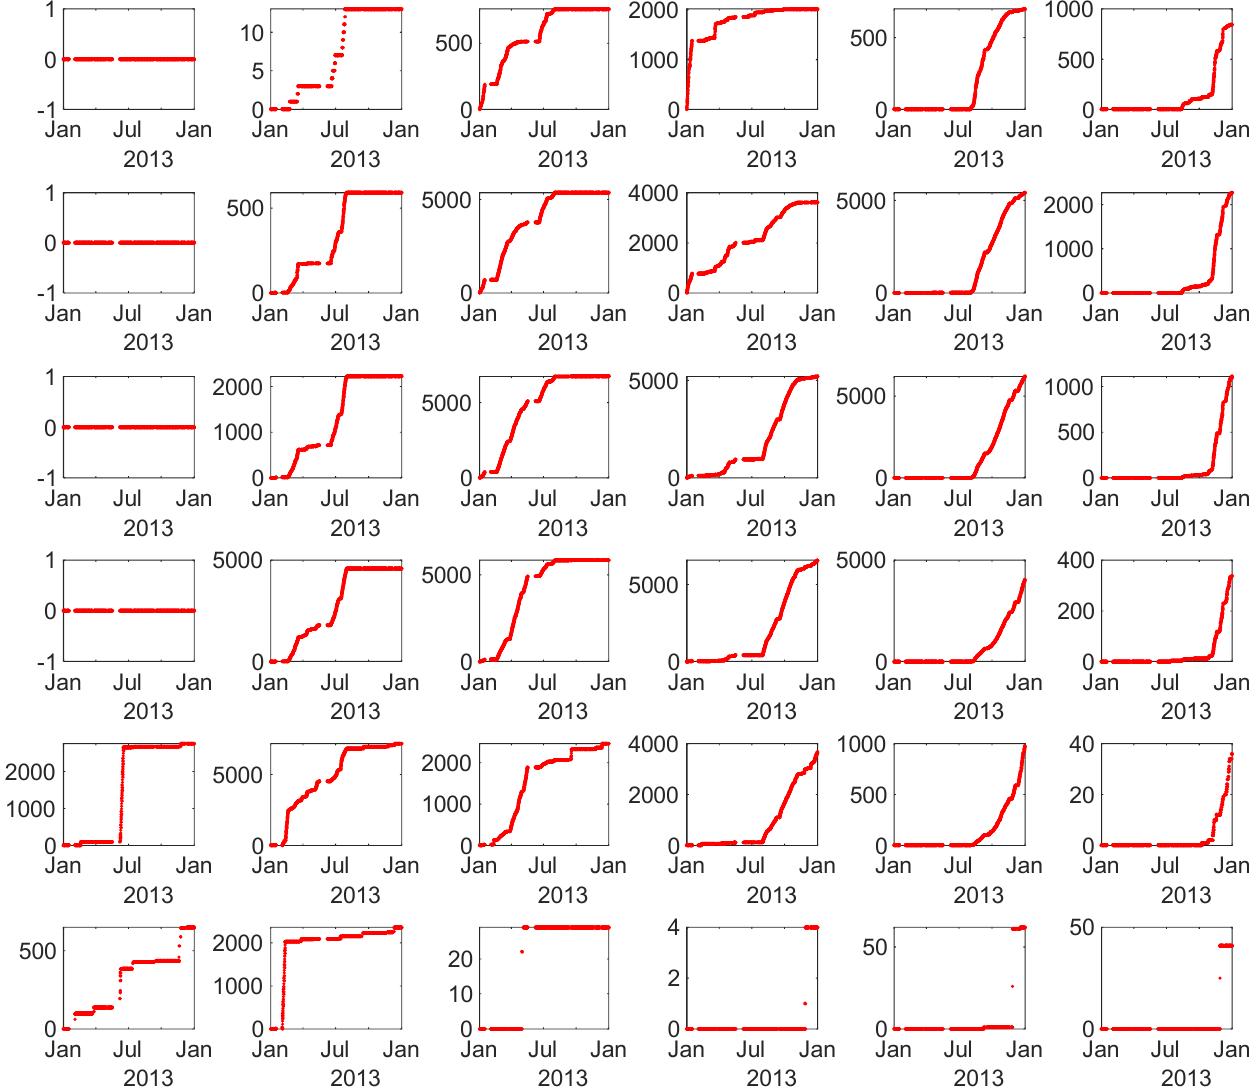
Figure 8. Alternative time series representation of Figure 7 showing each of the 36 quantile cells growth rates. Some cells go through periods of no growth, others are only visited at certain times of year.